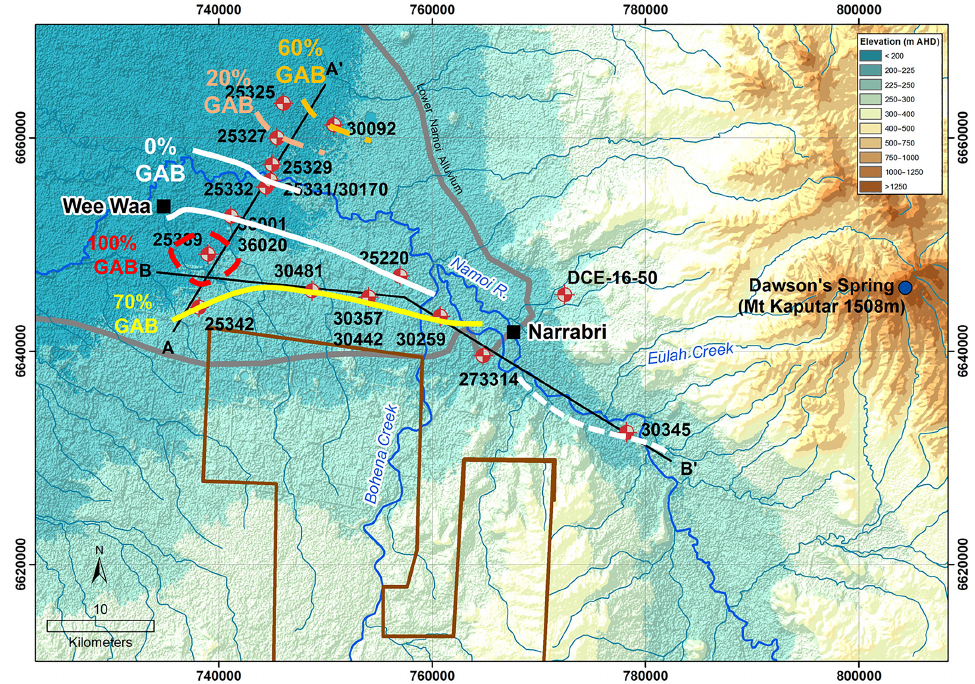
Figure 9. Approximate percentages of GAB contribution to the LNA, calculated from multiple geochemical tracers and major ion data. Table 1. Changes in 14 C content (pmc) in select boreholes in the study area between 1978 and 2016 (see Figs. 1 and 8 for the locations of the bores). The five bores in bold text highlight where we observe changes in the 14 C content from 1978 to this study. Where available, the season and/or year of sampling is included. ND: no data. Bore Depth interval Calf McLean ANSTO data